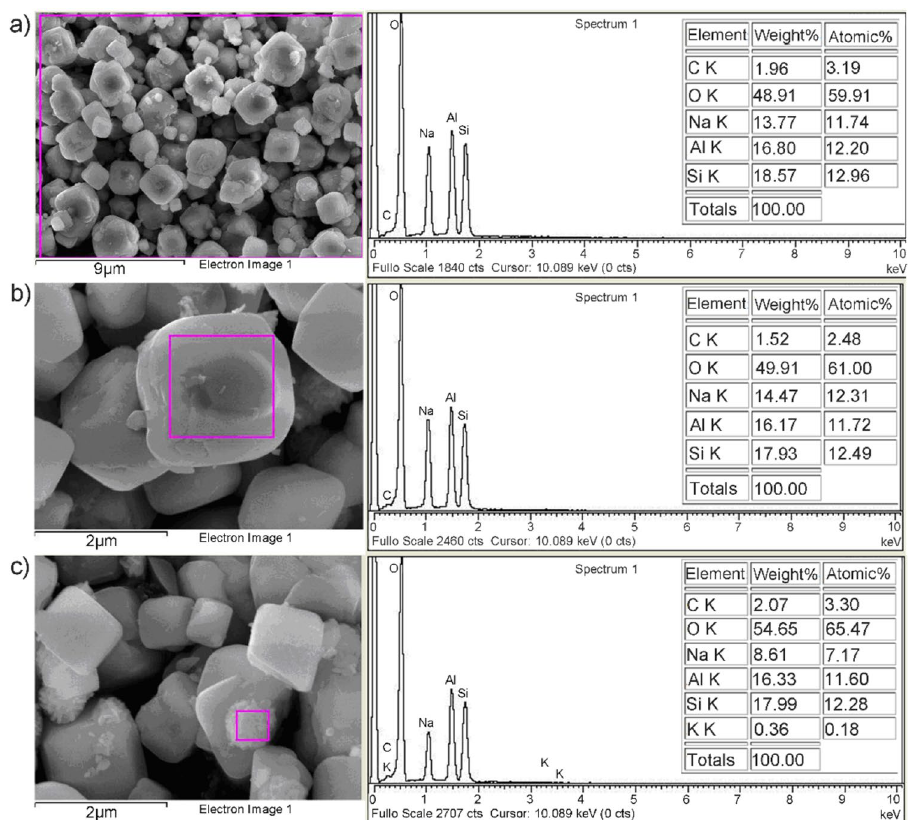
Figure 2. SEM/EDS analysis of Z4A: ( a ) bulk sample, ( b ) isolated cubic particle, and ( c ) isolated spherical